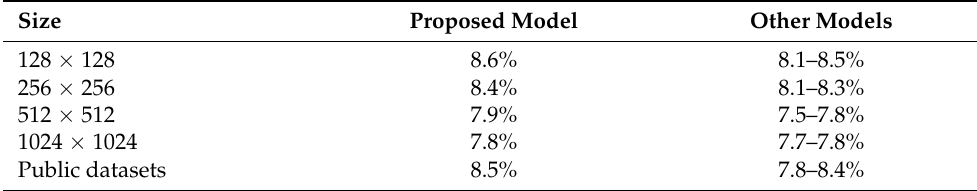
Table 3. Expected performance—compression ratios compared with those of other